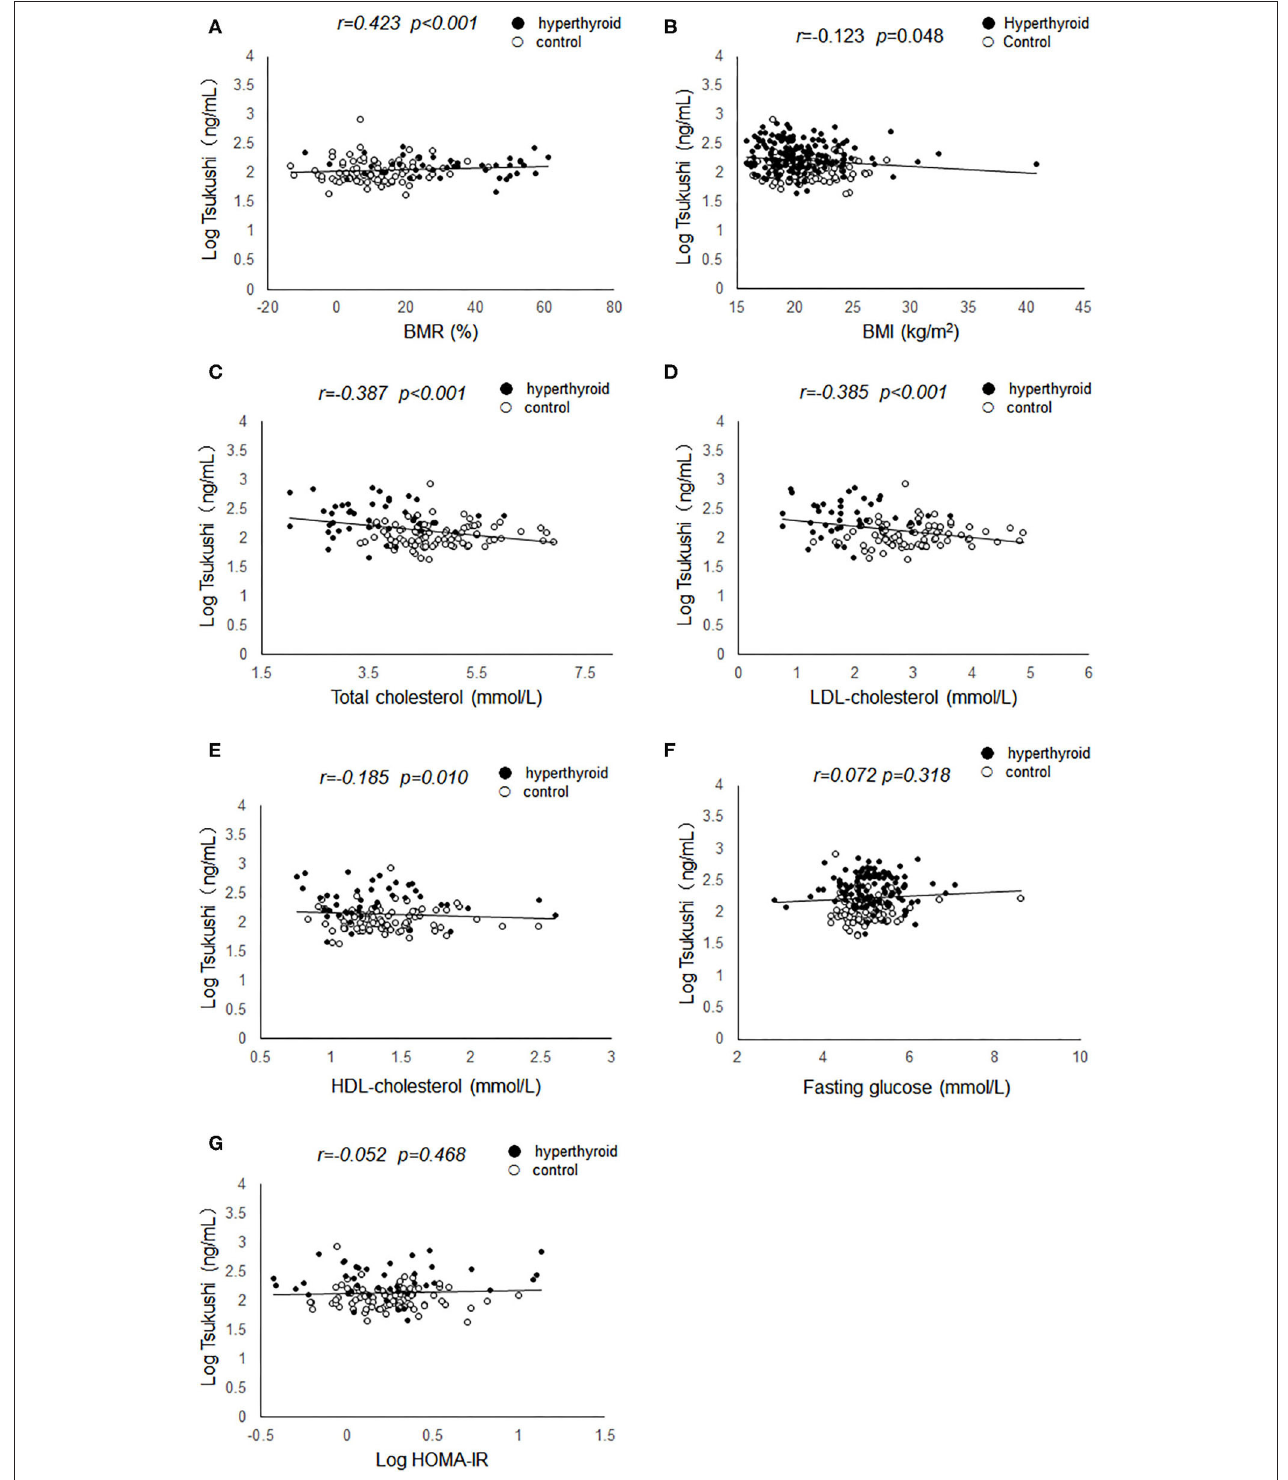
FIGURE 2 | Correlation of serum Tsukushi levels with metabolic variables. (A) Correlation of serum Tsukushi levels with BMR; (B) correlation of serum Tsukushi levels with BMI; (C) correlation of serum Tsukushi levels with serum levels of total cholesterol; (D) correlation of serum Tsukushi levels with serum levels of LDL-cholesterol; (E) correlation of serum Tsukushi levels with serum levels of HDL-cholesterol; (F) correlation of serum Tsukushi levels with serum levels of fasting glucose; (G) correlation of serum Tsukushi levels with serum levels of HOMA-IR; BMR, basal metabolic rate; BMI, body mass index; LDL, low density lipoprotein; HDL, high density lipoprotein; HOMA-IR, homeostasis model assessment of insulin resistance.